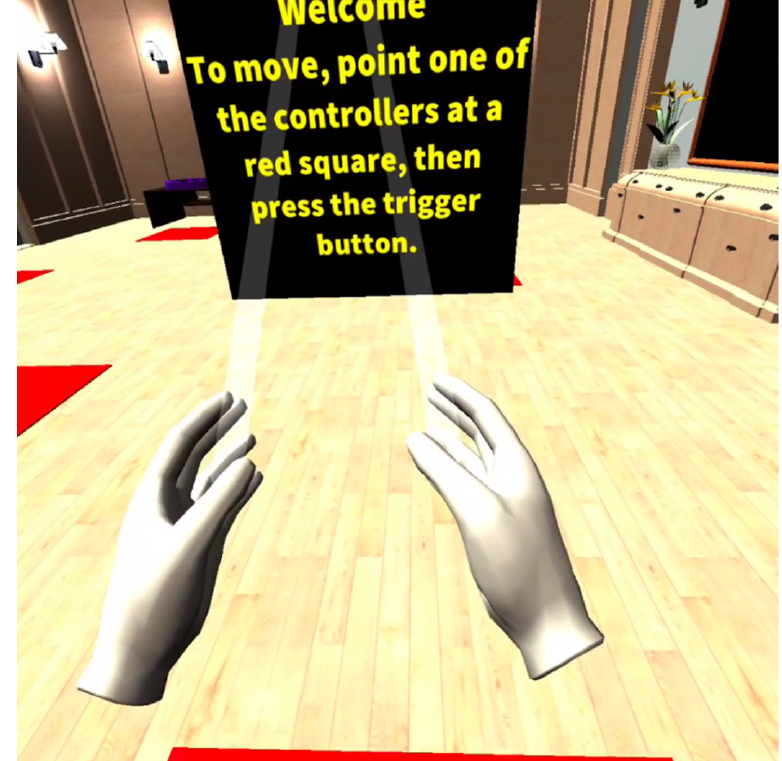
Figure 4. Virtual hands as represented in the VE. Table 1. VR FOUNDations Interactions.